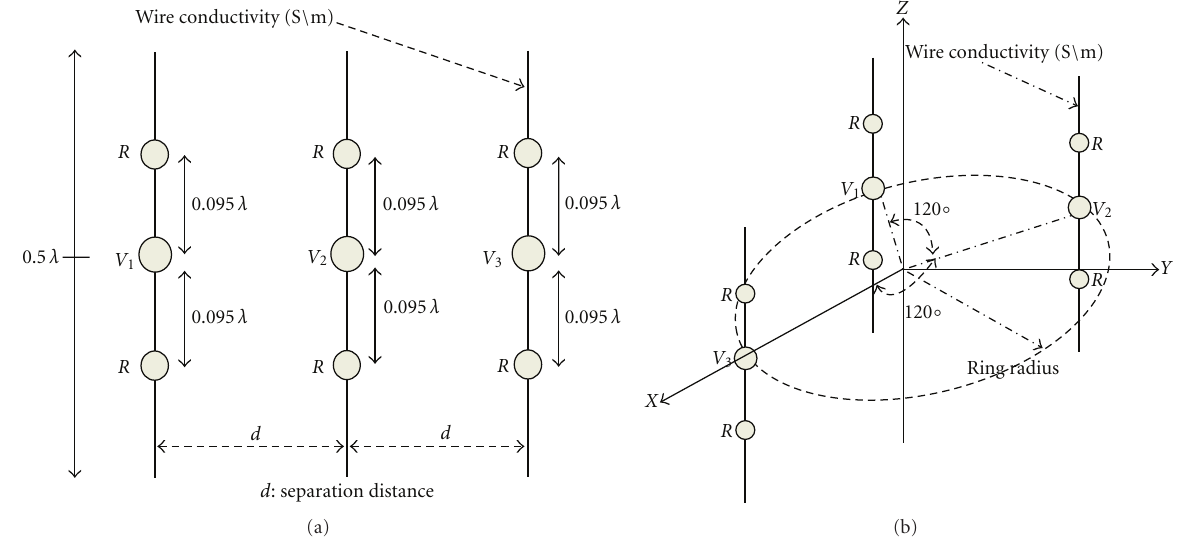
Figure 2: Examples under test: (a) Uniform linear array, (b) Ring